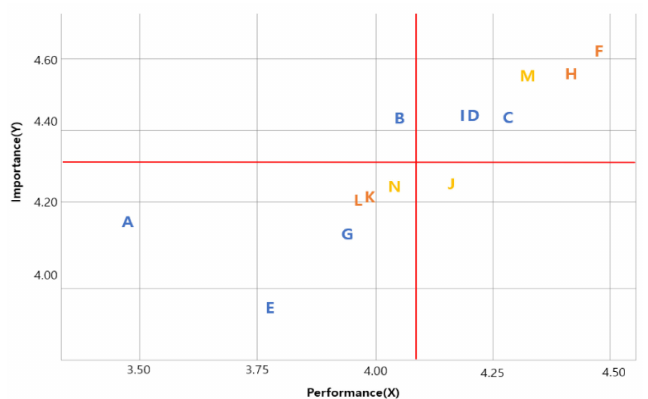
Figure 5. IPA (middle-aged group).